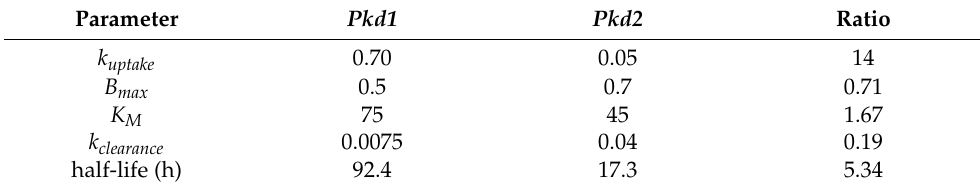
Table 1. Result table for mathematical modeling of Pkd mutant-derived EV data.